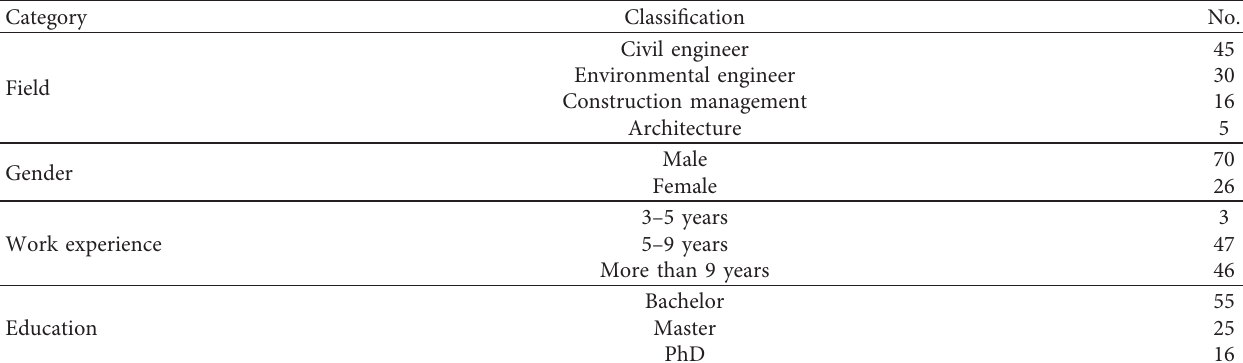
Table 4: Information about participated experts.